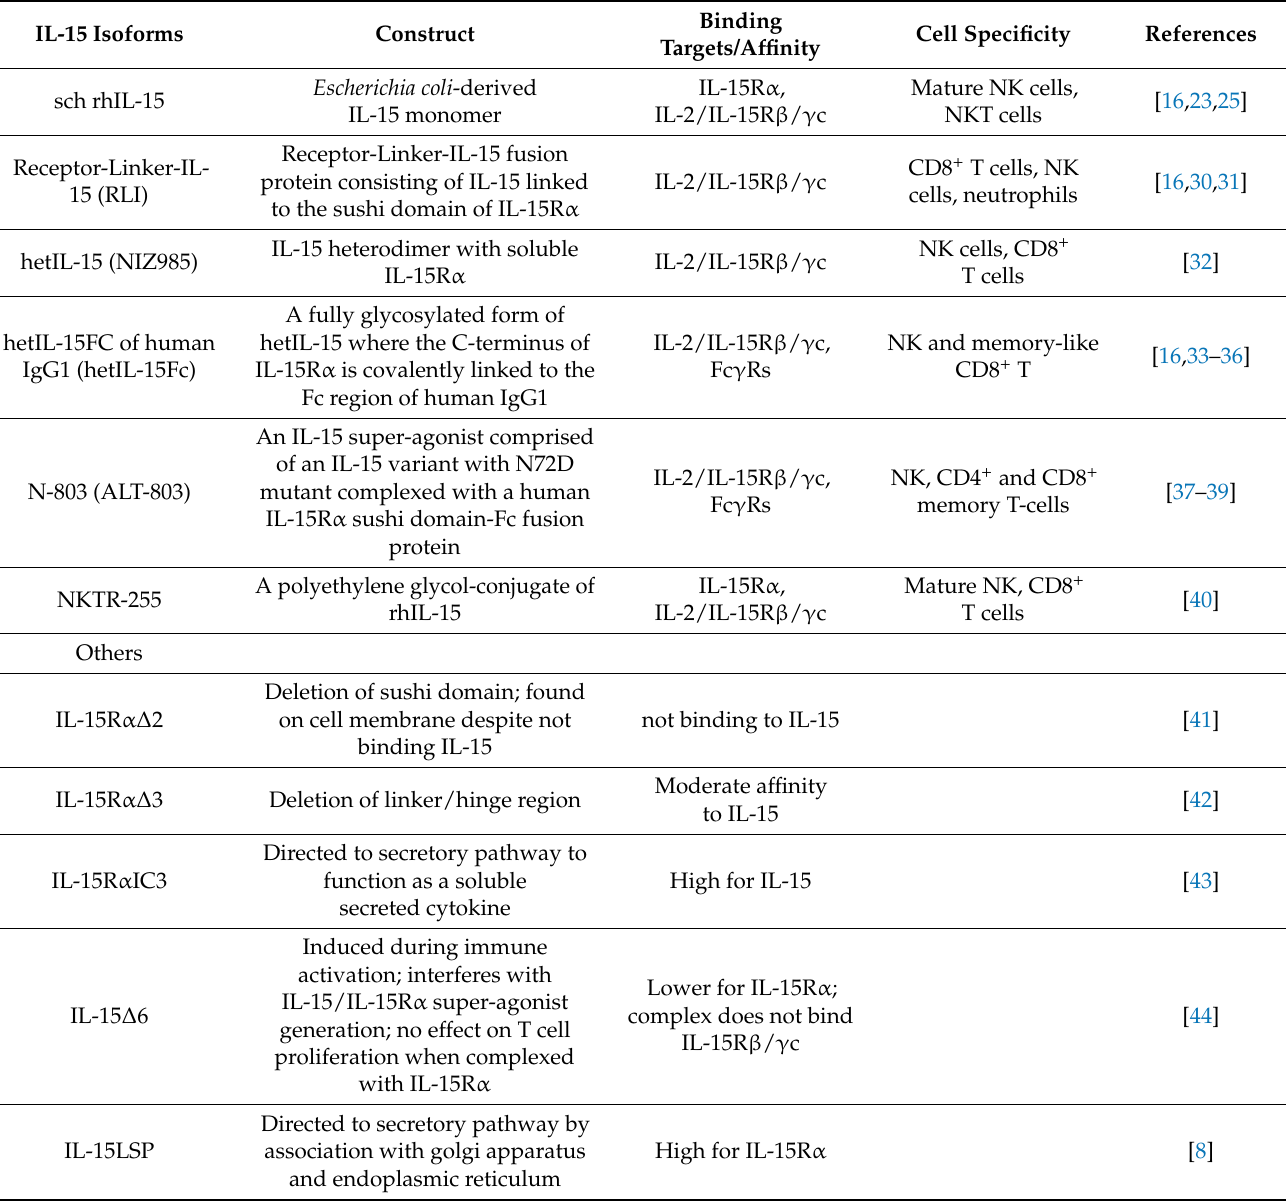
Table 1. IL-15/IL-15R α isoforms and their specific binding